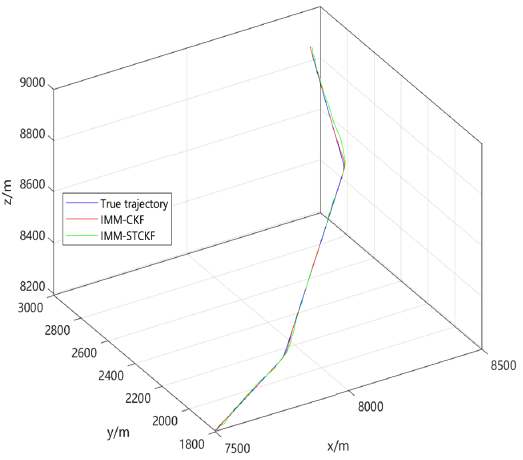
Figure 6. Tradition target maneuver trajectory. The traditional target has two state changes during maneuver, and IMM-CKF and IMM-STCKF track it.